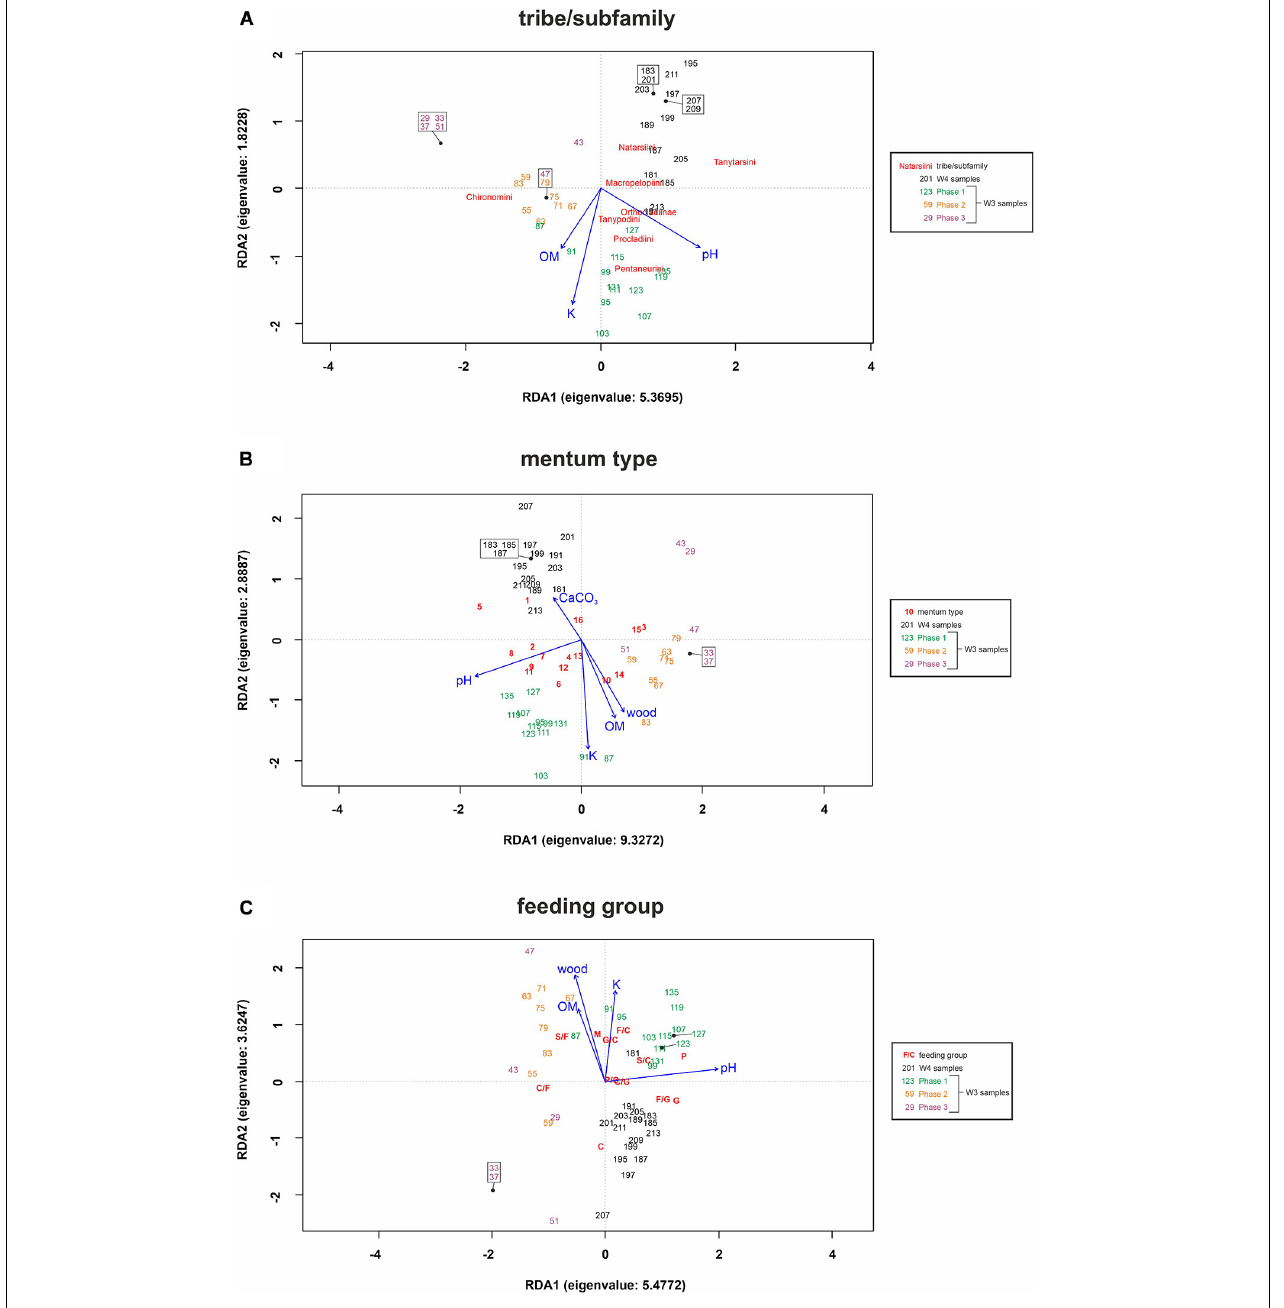
FIGURE 4 | Redundancy Analysis for tribes/subfamilies (A) , mentum types (B) and feeding groups (C) showing composition differences according to selected environmental factors (blue) in samples within two cores [W3(2) and W4]. The abbreviations used for functional feeding groups were as follows: C – collector-gatherers; C/F – collector-filterers; C/G – collectors/grazers; S/F – shredders/filterers; S/C – shredders/collectors; G – grazers/scrapers; G/C – grazers/collectors; F/C – filterers/collectors; F/G – filterers/grazers; M – miners; P – predators; and P/C – predators/collectors. The symbols used for morphological types are explained in Table 1 . For full names of variables, see Supplementary Table 1